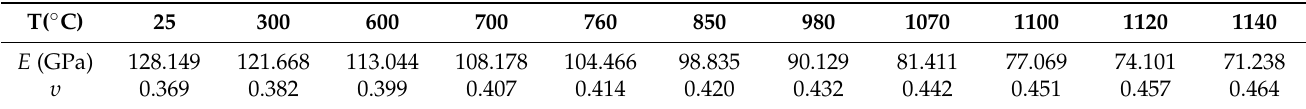
Table 4. Material parameters for DD10.